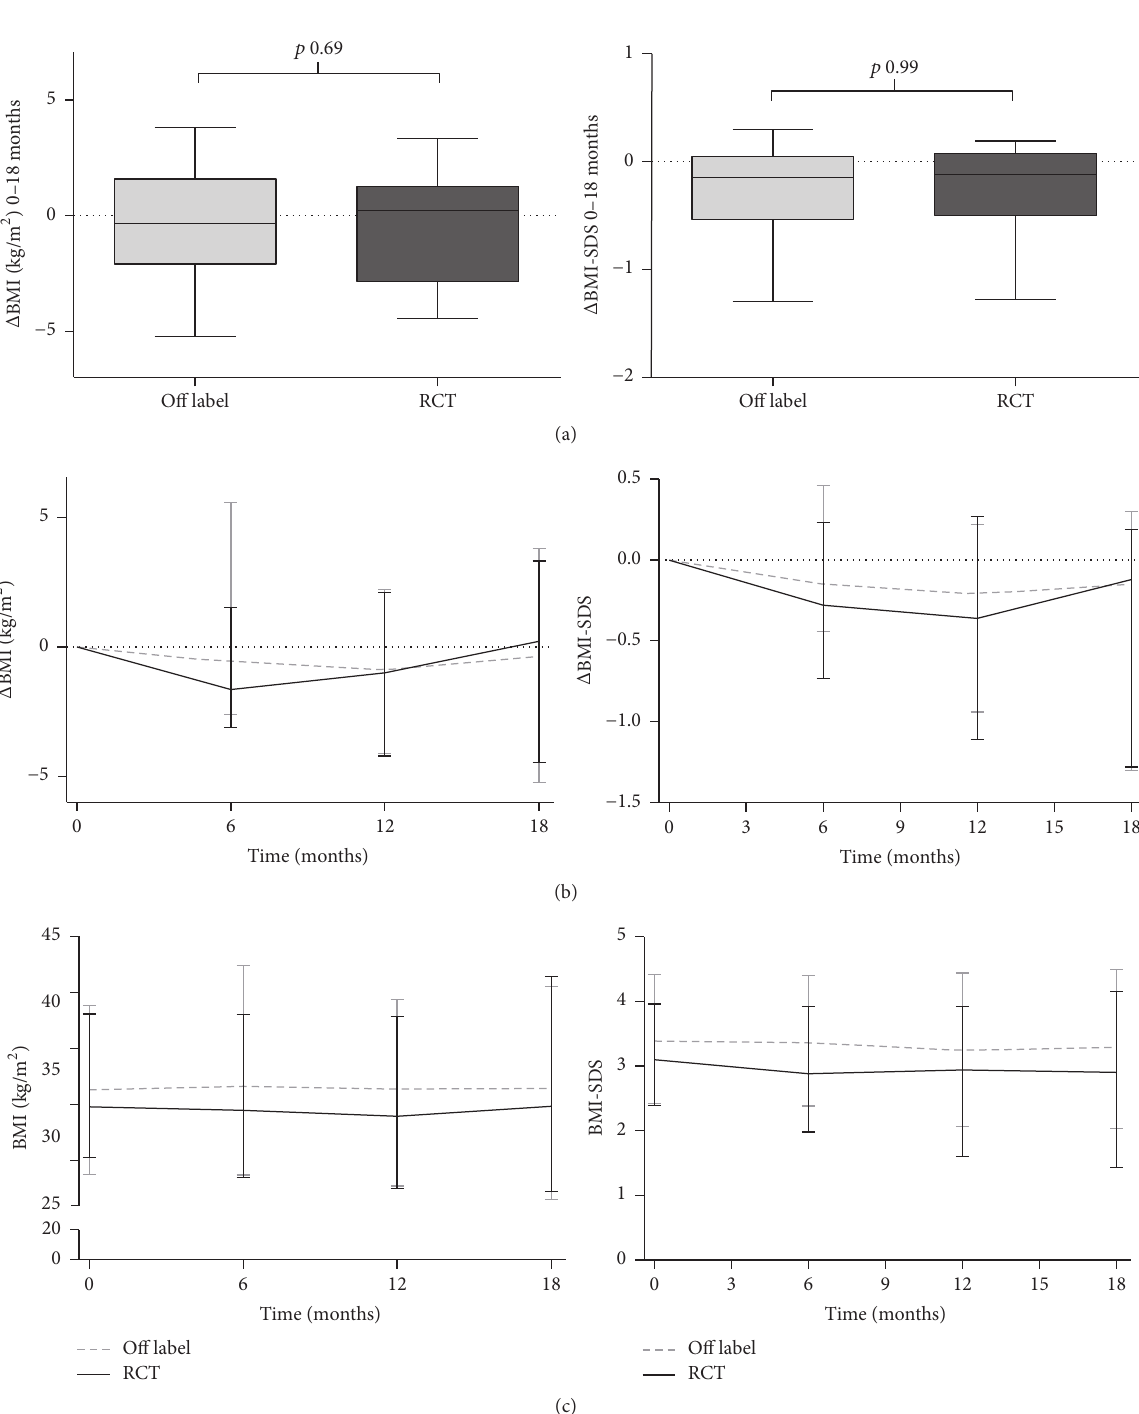
treatment with metformin in daily clinical practice is a possi- ble explanation. The clinician might tend to reserve off label treatment with metformin for children with seriously inc- reased levels of FPG, FPI, or HOMA-IR. Another explanation could be the difference in ethnicity between both